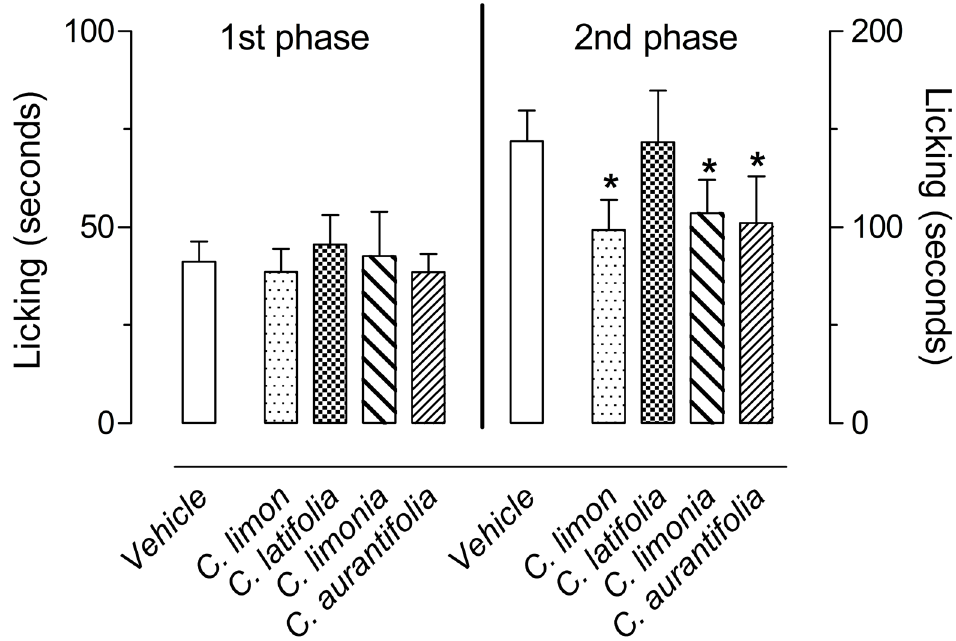
Fig 1. Effects of C . limon , C . latifolia , C . limonia and C . aurantifolia essential oils on the formalin- induced licking response in mice. Animals were pre-treated with oral doses of 100 mg/kg dose of each essential oil or vehicle. The results are presented as the mean ± S.D. (n = 6 per group) of the time that the animal spent licking the formalin-injected paw. Statistical significance was calculated by ANOVA followed by Bonferroni's test. * P < 0.05 when compared to vehicle-treated mice.